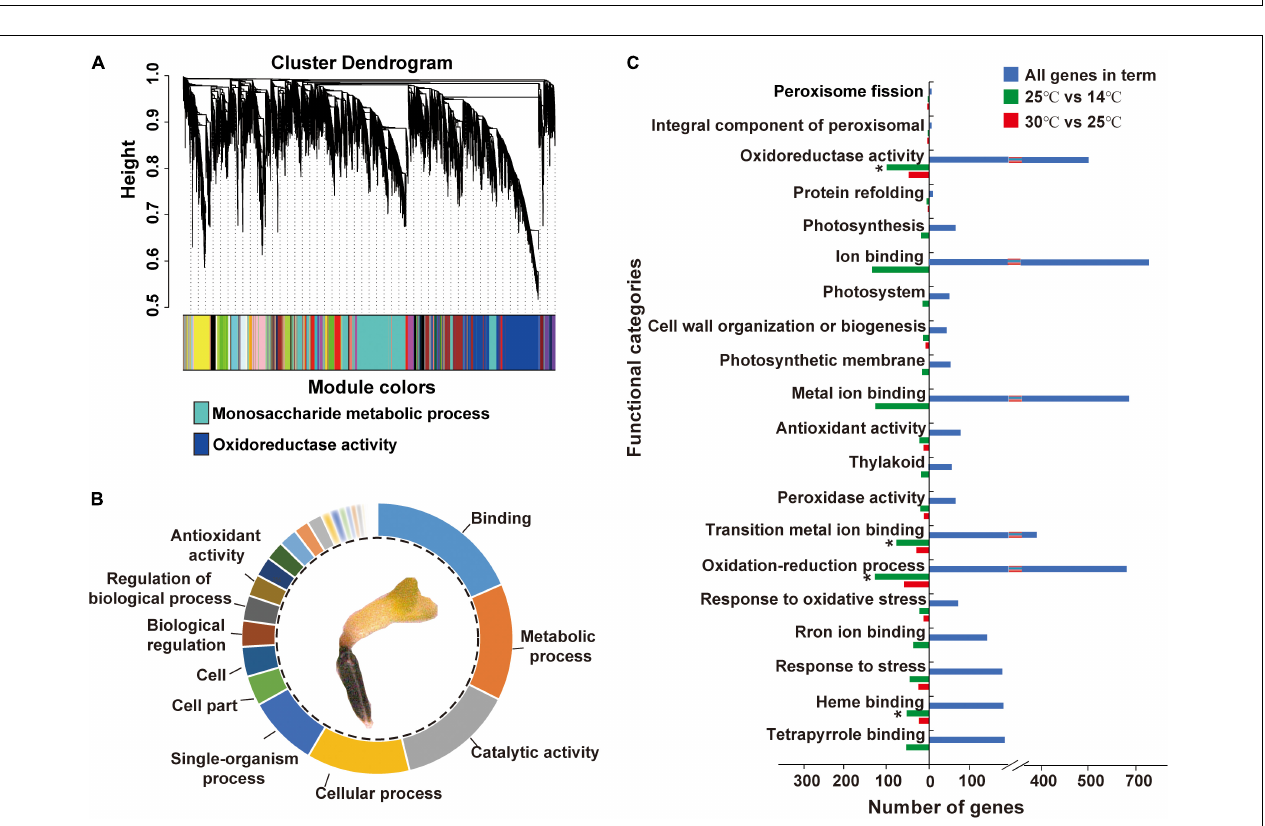
FIGURE 3 | Differentially expressed genes (DEGs) and their gene ontology (GO) annotations during the imbibition of M. micrantha seed. (A) Hierarchical cluster analysis of genes from the M. micrantha transcriptome. The co-expression clusters are assigned as different colors. (B) Functional distributions of gene ontology